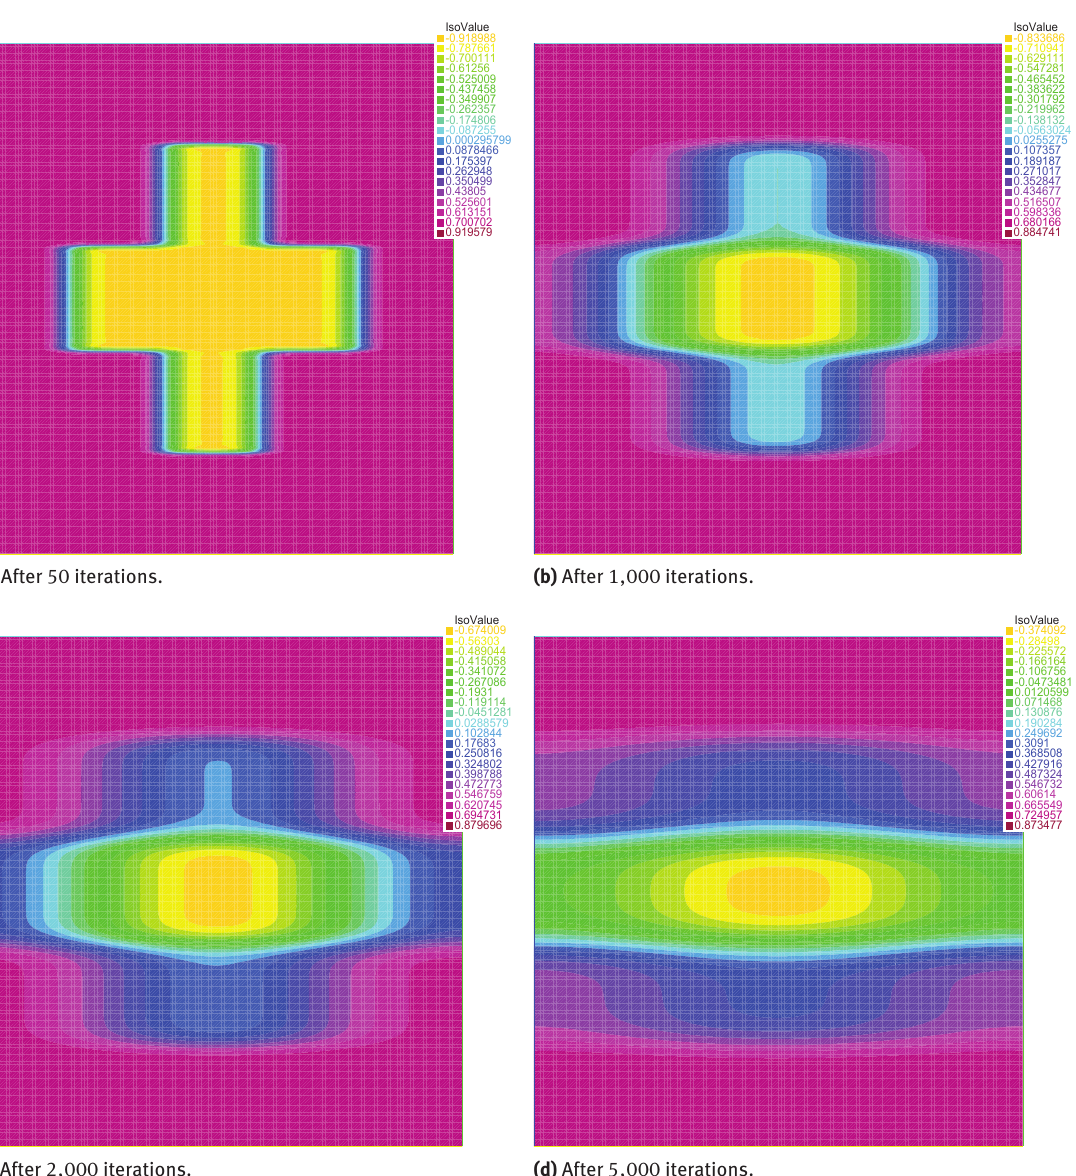
Figure 8: Results for k = 1, dt = 10 − 5